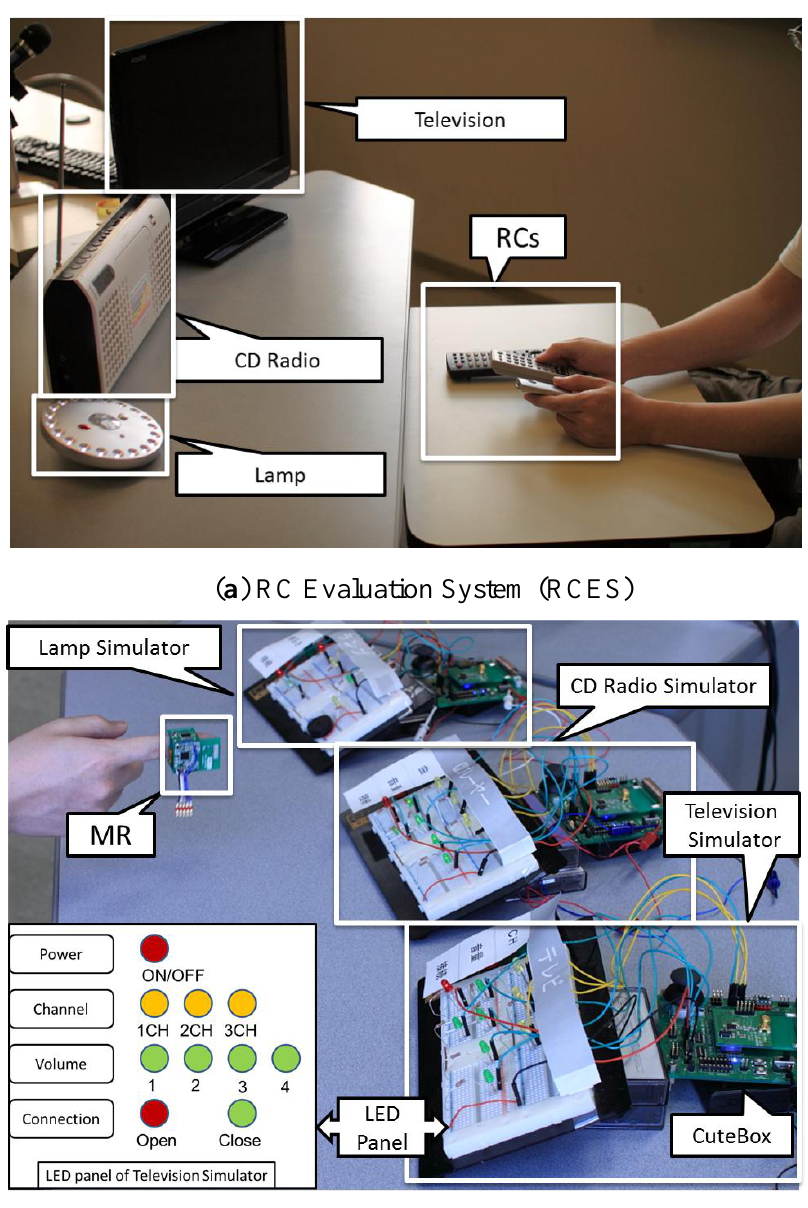
Figure 7. Setting of the two comparative evaluation